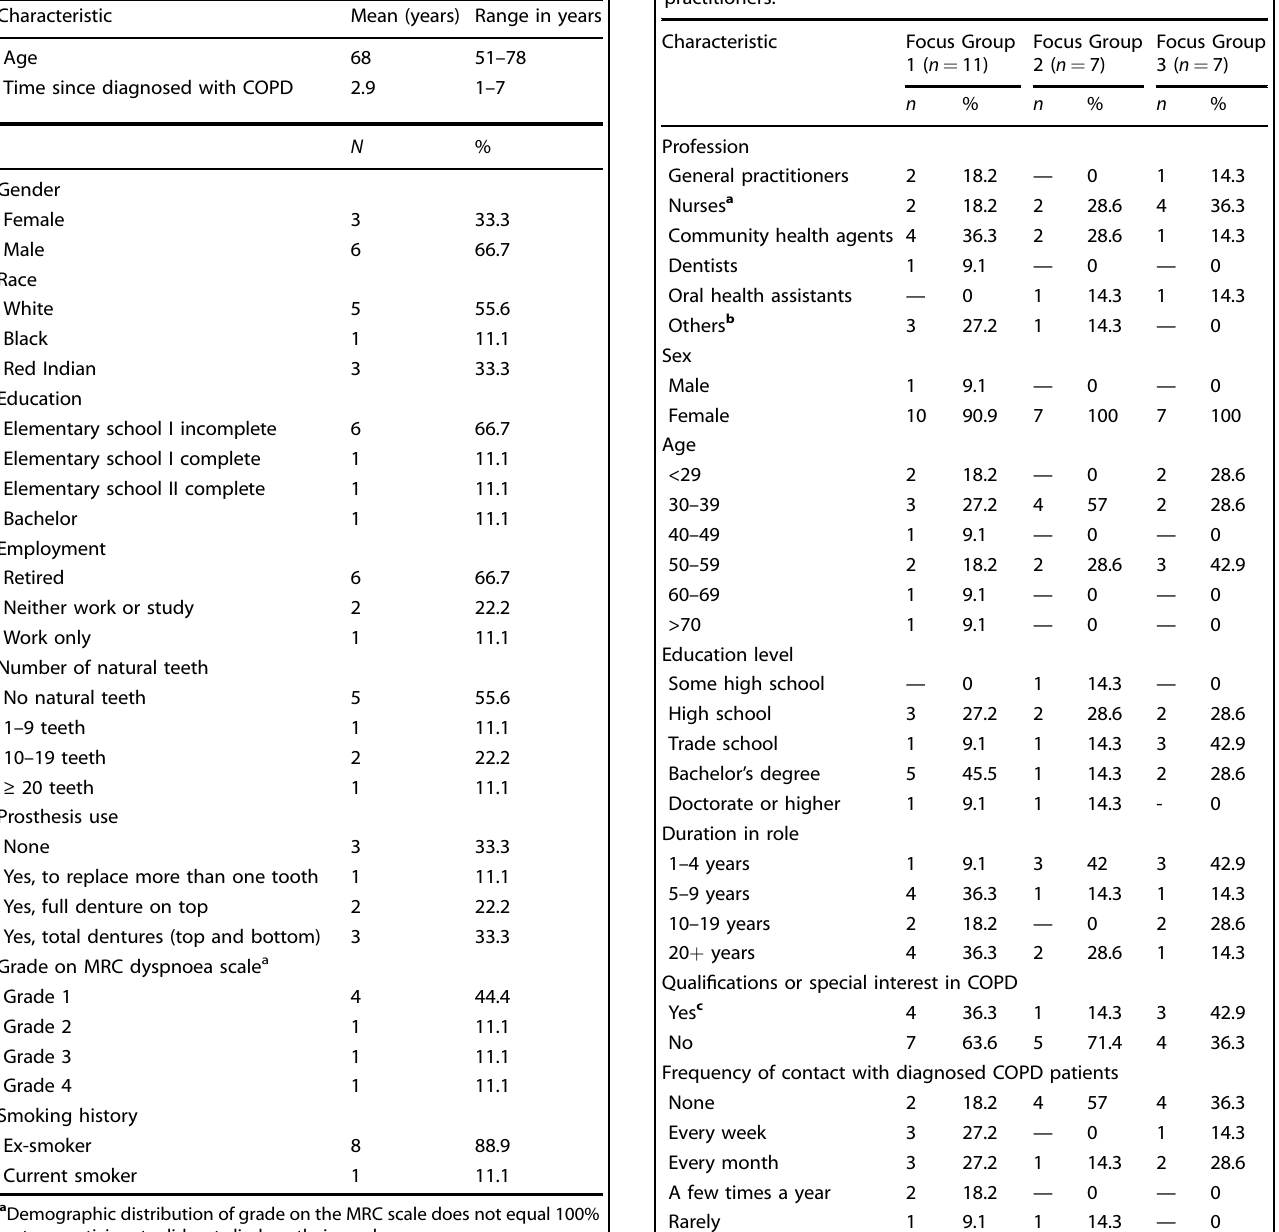
Table 1. Characteristics of interviewed COPD patients. Table 2. Characteristics of participating family health strategy